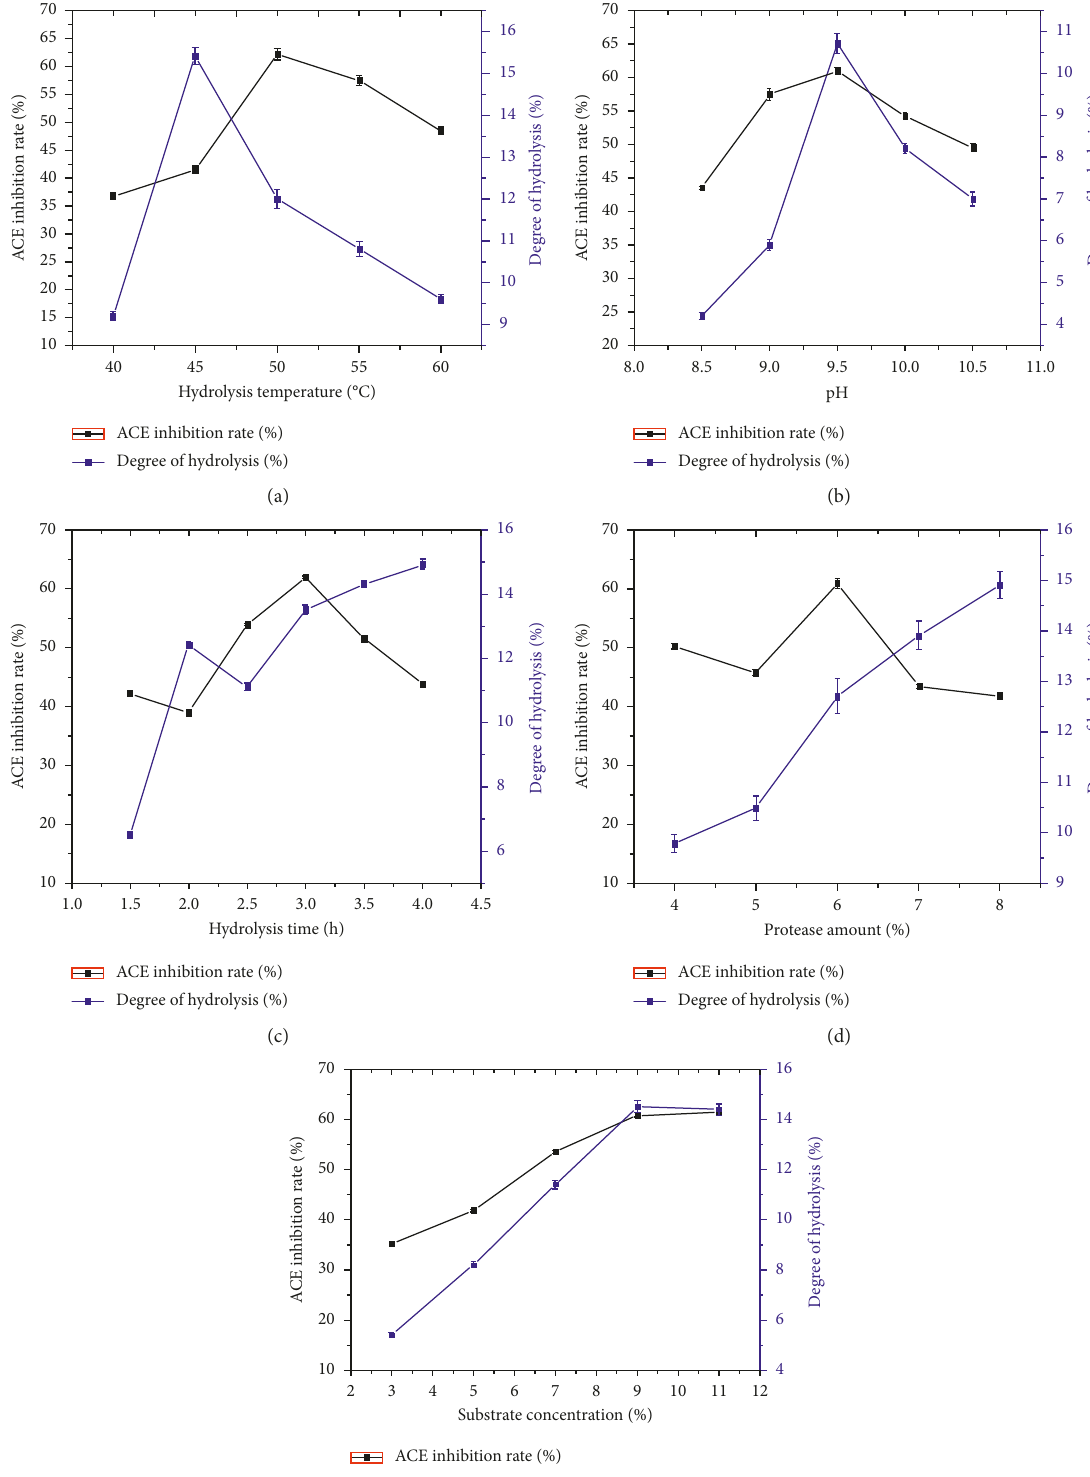
Figure 2: Influence of the selected factors on the DH and ACE inhibitory rate hydrolysate by alkaline protease: (a) hydrolysis temperature; (b) pH; (c) hydrolysis time; (d) protease amount; (e) substrate